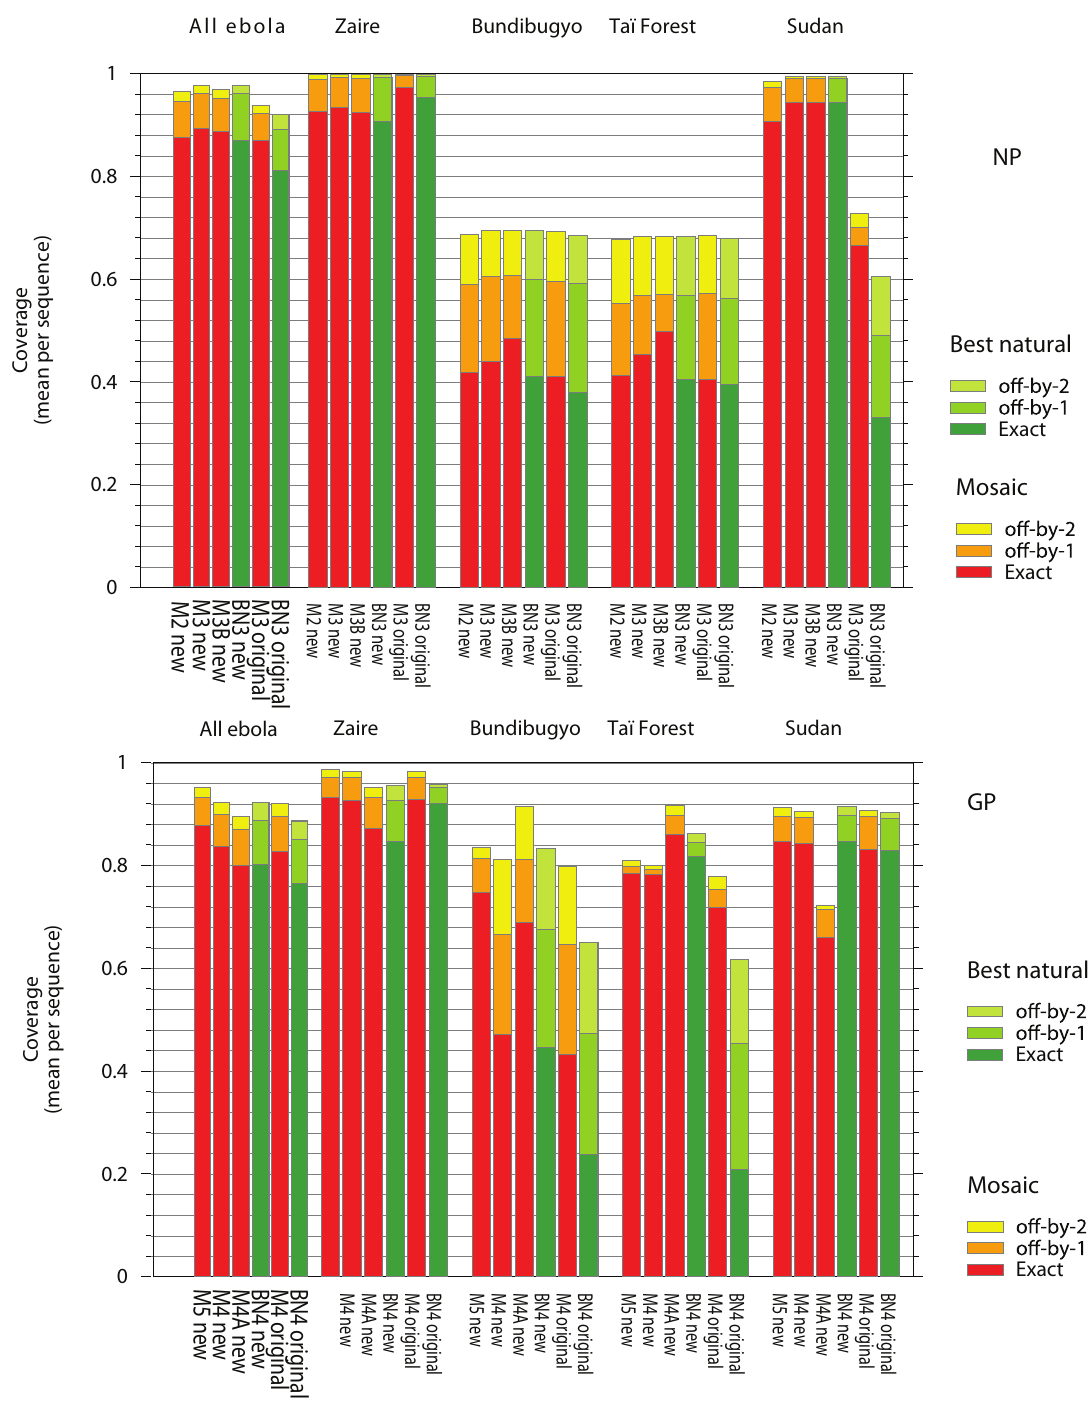
Figure 1. Sequence-averaged 9-mer coverage by vaccines composed of cocktails or proteins. M n designates a mosaic cocktail containing n co-optimized proteins. BN n designates a best natural cocktail containing n proteins. ‘‘Original’’ refers to coverage of the new sequence set by a vaccine using the original sequence set as input. ‘‘New’’ refers to coverage of the new sequence set by vaccine designed against the new sequence set. M n A refers to a mosaic with a serial optimization strategy. M n B refers to re-weighting of clades by the duplication of sequences in the final design set (see Methods). doi:10.1371/journal.pone.0044769.g001 potentially rare epitopes is invariably larger, rising as high as 60, mosaics. The number of these non-natural k -mers in the mosaic from a total number that approximately ranges from 400 to 500 (i.e. that are absent from the new set of filoviral proteins) is never depending on k -mer length and protein (see the caption for more than 3.8% of all k -mers (for k = 12), with the absolute Figure 4 for precise numbers). number never exceeding 14 (see figure 1a). The number of